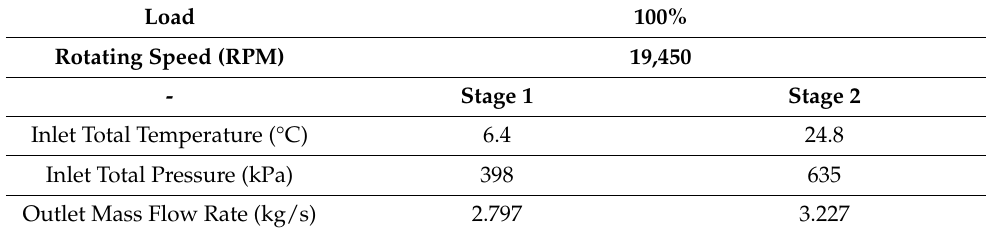
Figure 8. Joint of impeller and diffuser of mesh. (Stage 2). Table 5. Boundary conditions for two-stage IPLV load